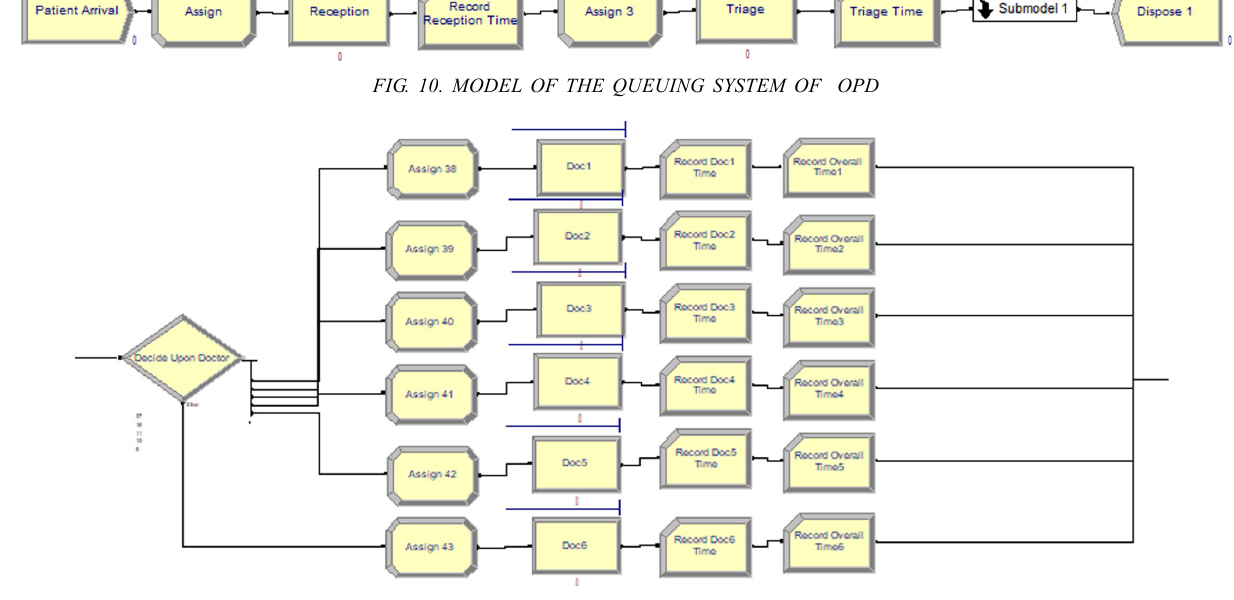
FIG. 11. SUB MODEL DEVELOPED FOR THE REPRESENTATION OF SERVICE MECHANISM OF PATIENTS BY THE DOCTOR AT THE